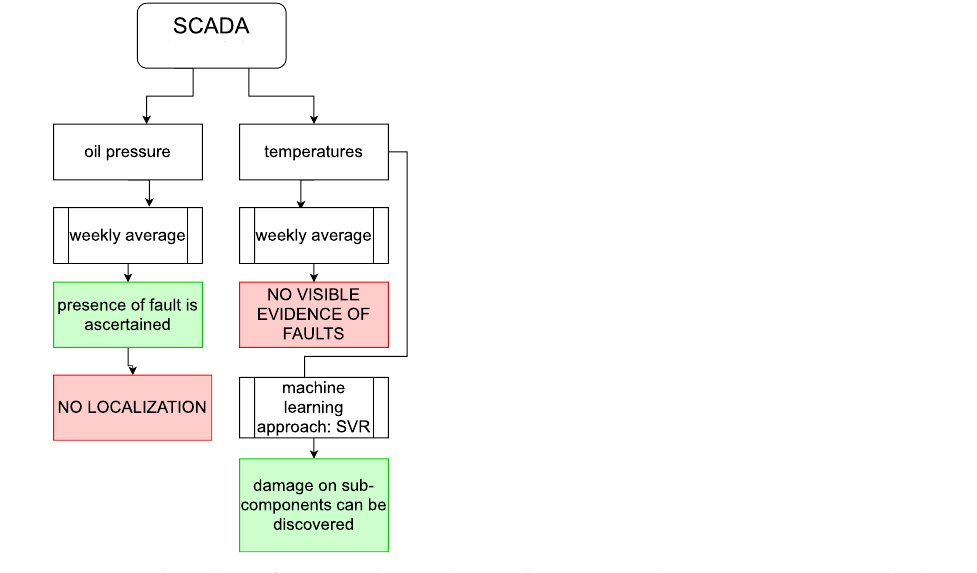
Figure 2. Flow chart of SCADA data analysis: oil pressure and temperatures were studied in parallel to obtain a comprehensive overlook of the turbine’s